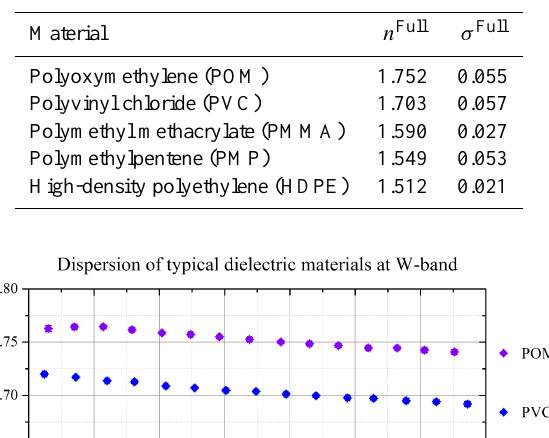
Table 1. Average refractive indices of different plastics at W-band frequencies.